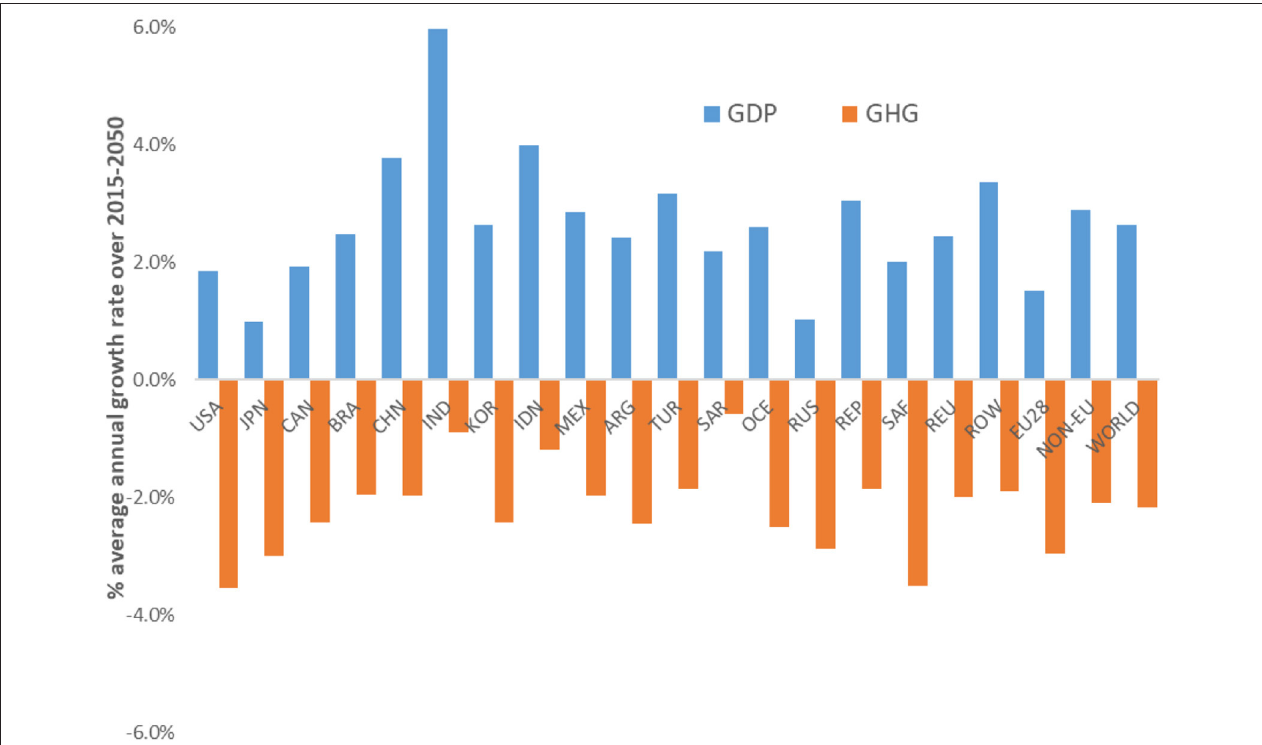
FIGURE 7 | Evolution of GDP and GHG emissions in major economies in the 2DEG